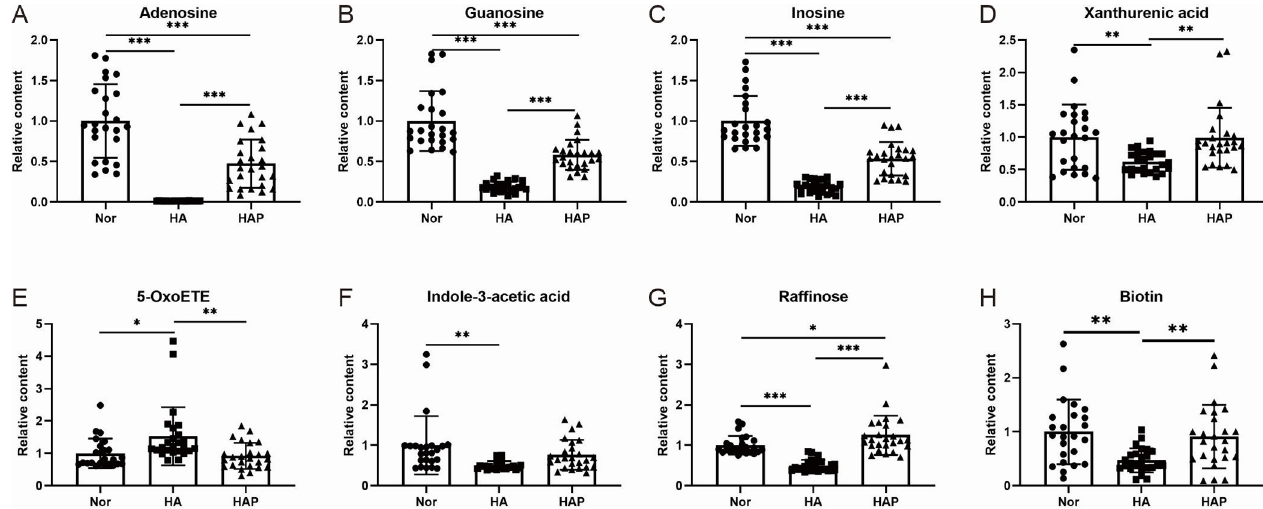
Fig 6. Plots representing the relative content of (A) Adenosine, (B) Guanosine, (C) Inosine, (D) Xanthurenic acid, (E) 5-OxoETE, (F) Indole-3-acetatic acid, (G) Raffinose, and (H) Biotin in three groups.